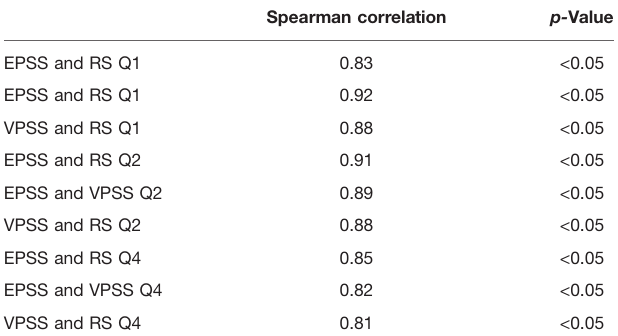
TABLE 3 | Spearman ’ s correlation of each question between VPSS, EPSS, and RS. Spearman